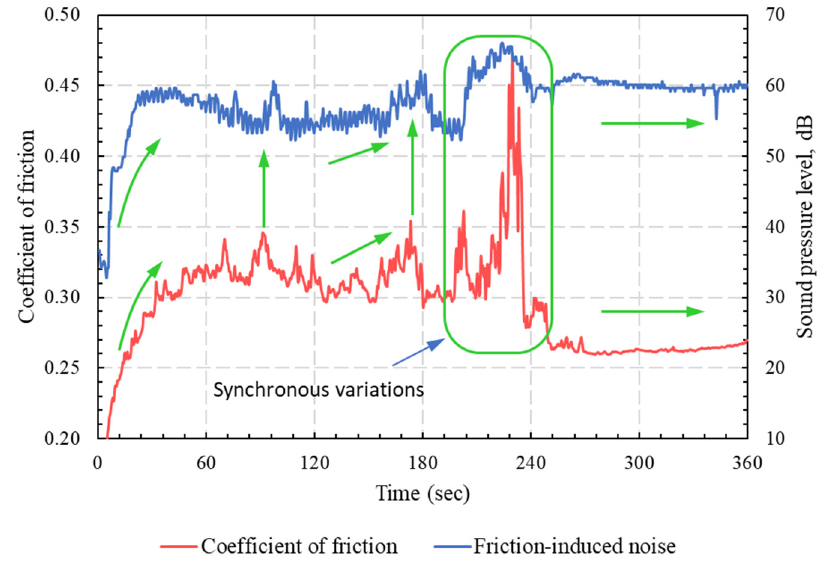
Figure 8. Synchronous behavior of the friction coefficient and the friction-induced noise for XY- oriented specimens.